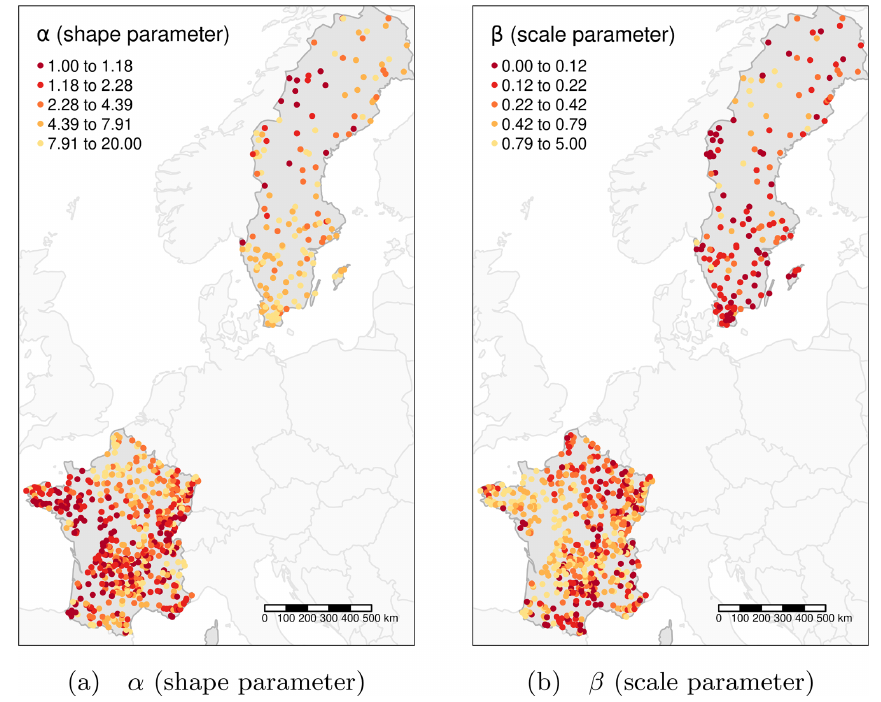
Figure B1. Map of the parameters of the Gamma distribution (Eq. 3) calibrated inside Eq. (2). The classes are delimited by quantile values.